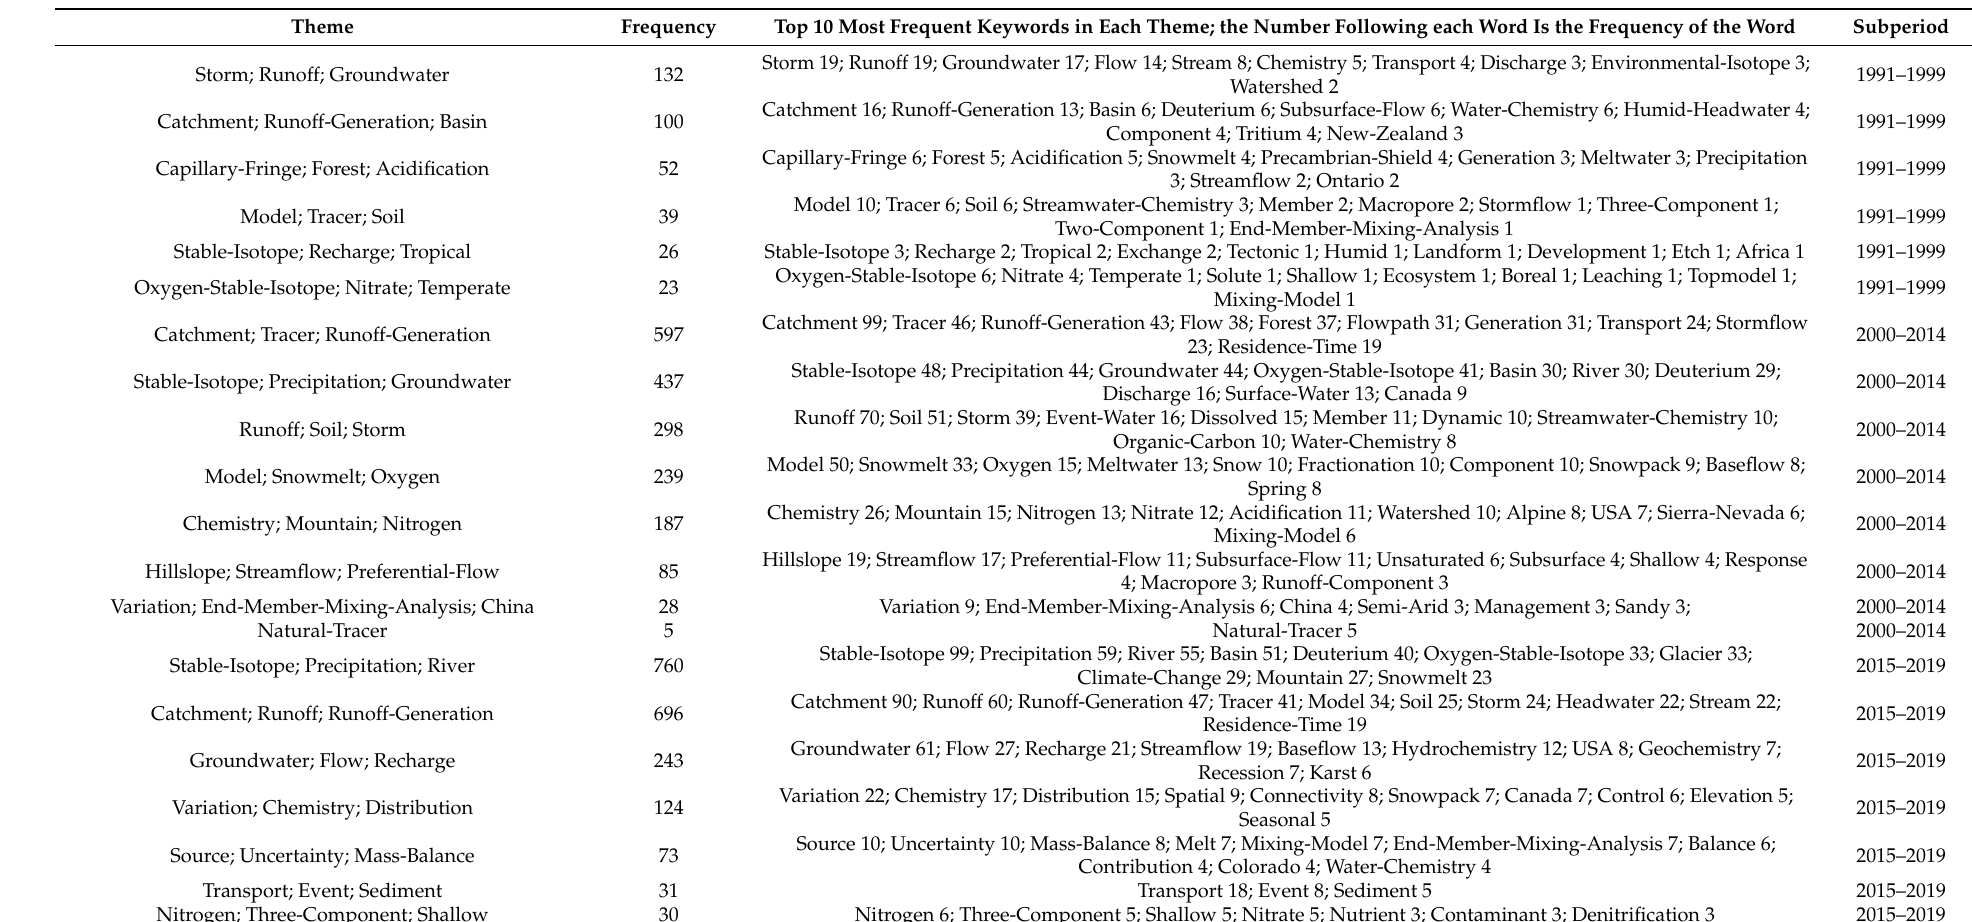
Table 5. Keywords of IHS themes in each